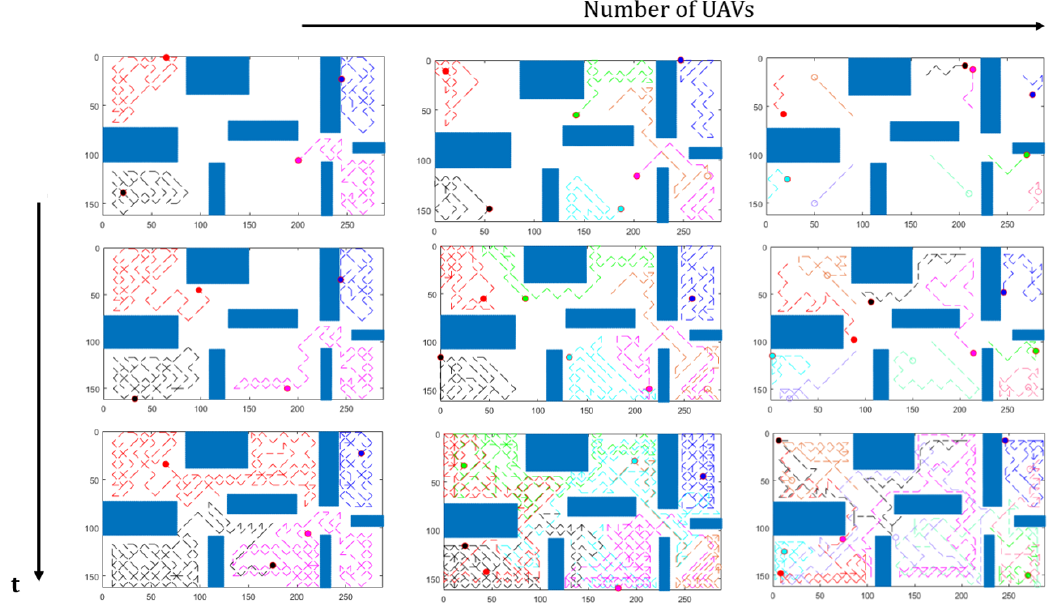
Figure 7. Temporal evolution of the fleet performing the coverage task in the Field4 map. Simulations are performed with a fleet composed of 4, 7, and 10